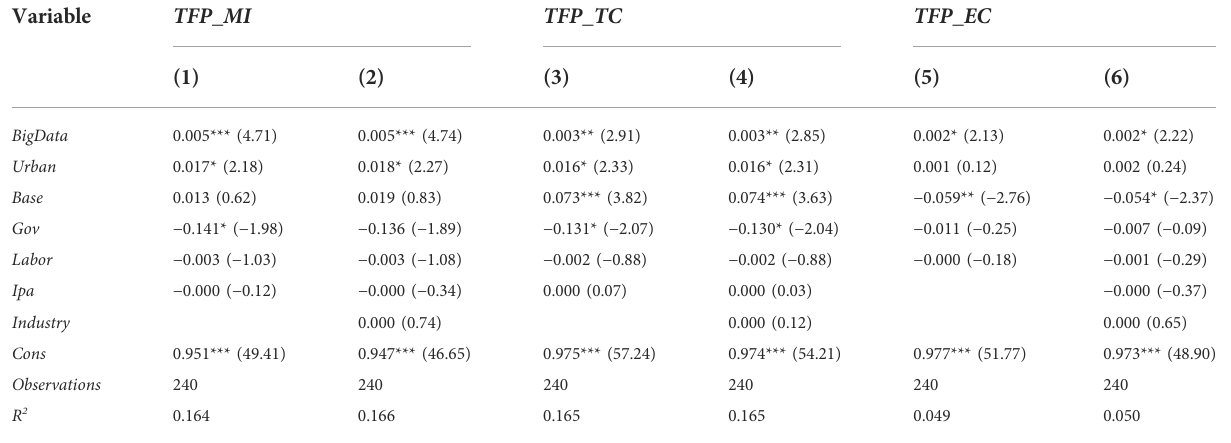
TABLE 11 Robustness test for adding control